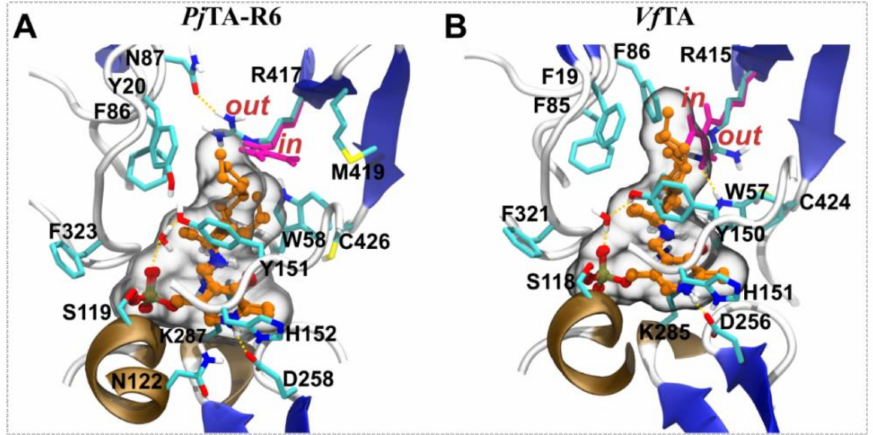
Figure 4. Docking structures of the external aldimine intermediates of amines A1 – A5 . ( A ). Pj TA-R6 and ( B ) Vf TA. The “out” conformation of the switching arginine is preferred for longer substituents ( A4 and A5 ), whereas the shorter alkyl substituents ( A1 to A3 ) show no preference for either conformation. The large binding site of Pj TA-R6 is less hydrophobic than the binding site of Vf TA (N87, Y20, and F86 for Pj TA-R6 and F86, F19, and F85 for Vf TA, respectively). The superimposed external aldimine structures of A1 – A5 are shown in CPK representation. The “in” conformation of Arg417 / Arg415 is colored